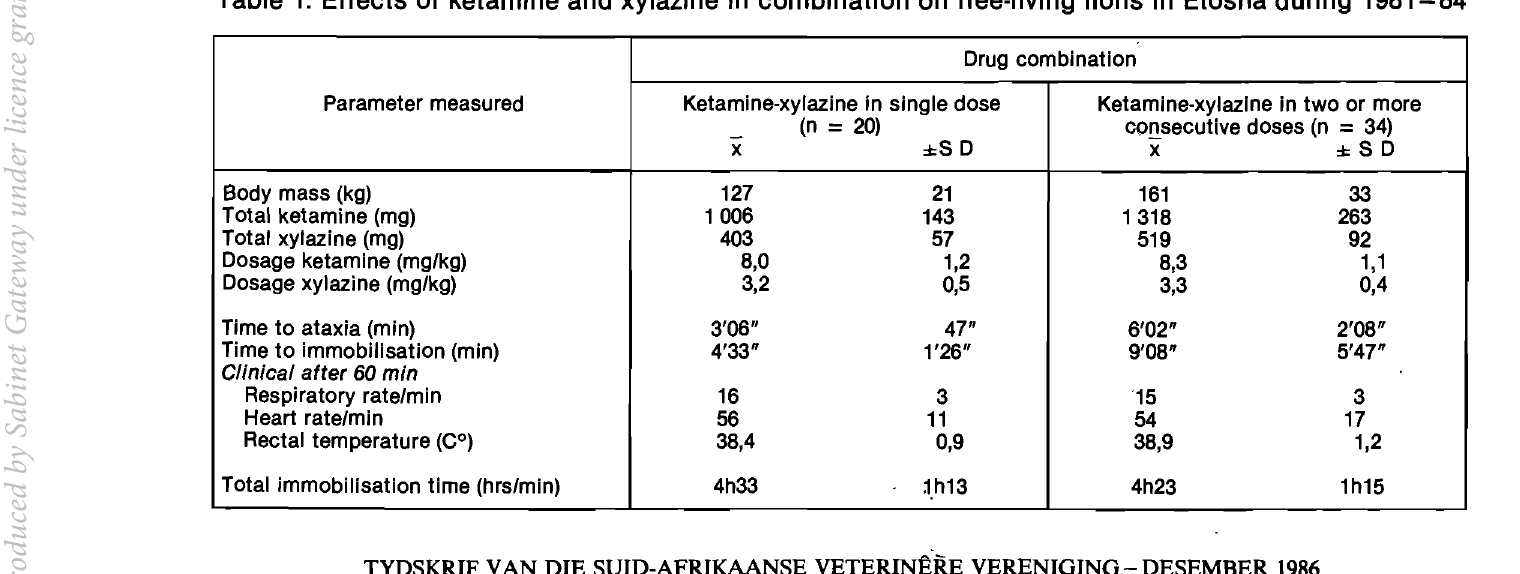
Table 1. Effects of ketamine and xylazine in combination on free-living lions in Etosha during 1981-84